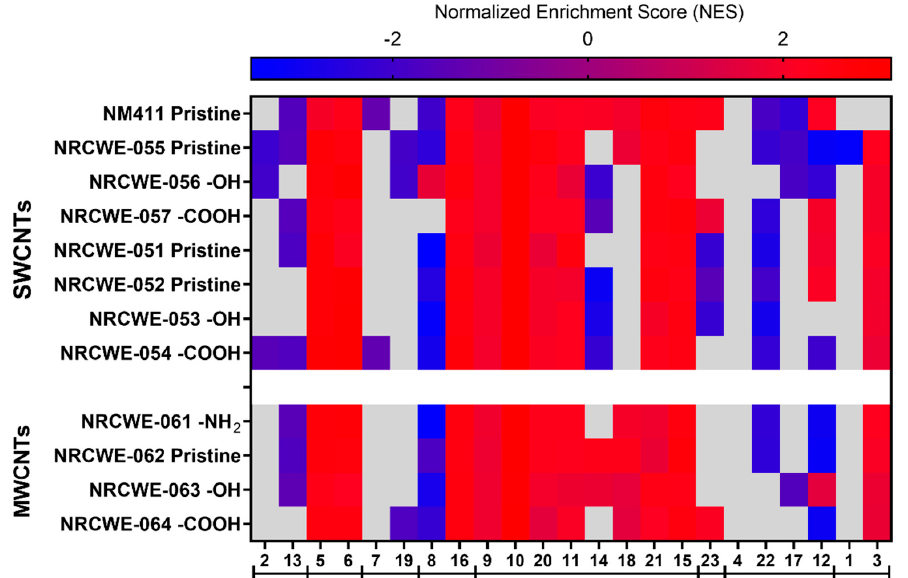
Figure 10. Modules over-represented or under-represented after 1 day of exposure to CNTs at the 54 µ g/mouse dose. Red: positive NES values represent gene set enrichment at the top of the ranked list. Blue: negative values represent gene set enrichment at the bottom of the ranked list. Enriched sets were considered significant if their NES had an adjusted p -value ≤ 0.05 (gray represents modules that were not significant). The bars group the modules with similar biological functions based on the IPA analysis.